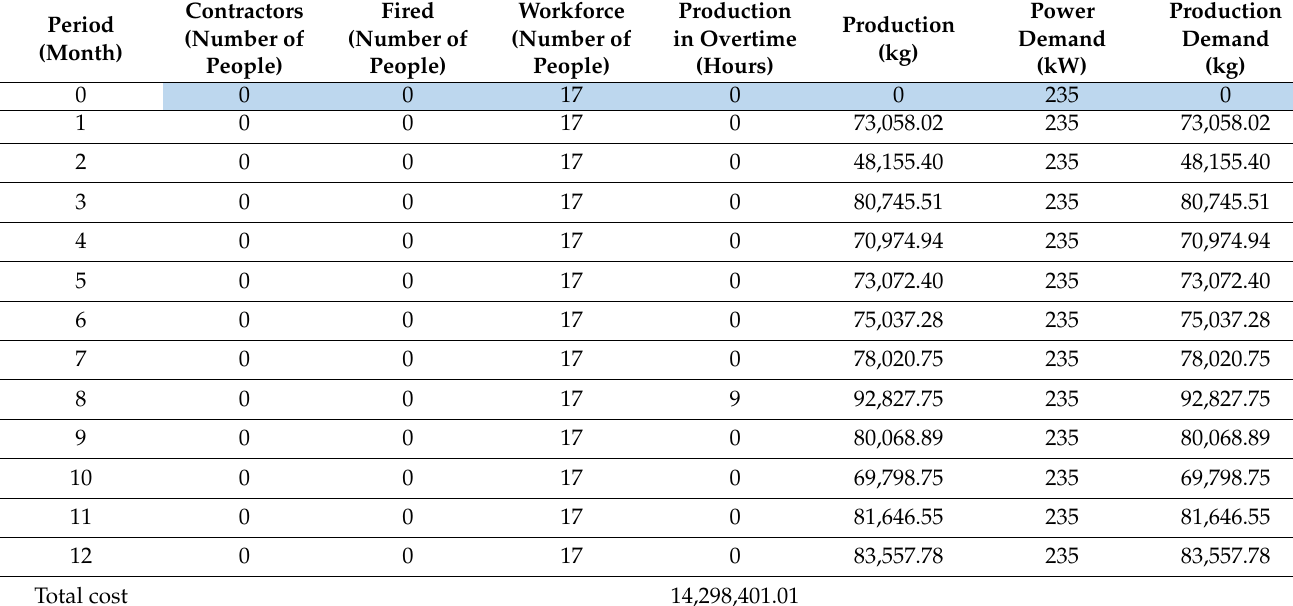
Table 5. Aggregate plan with the proposed power